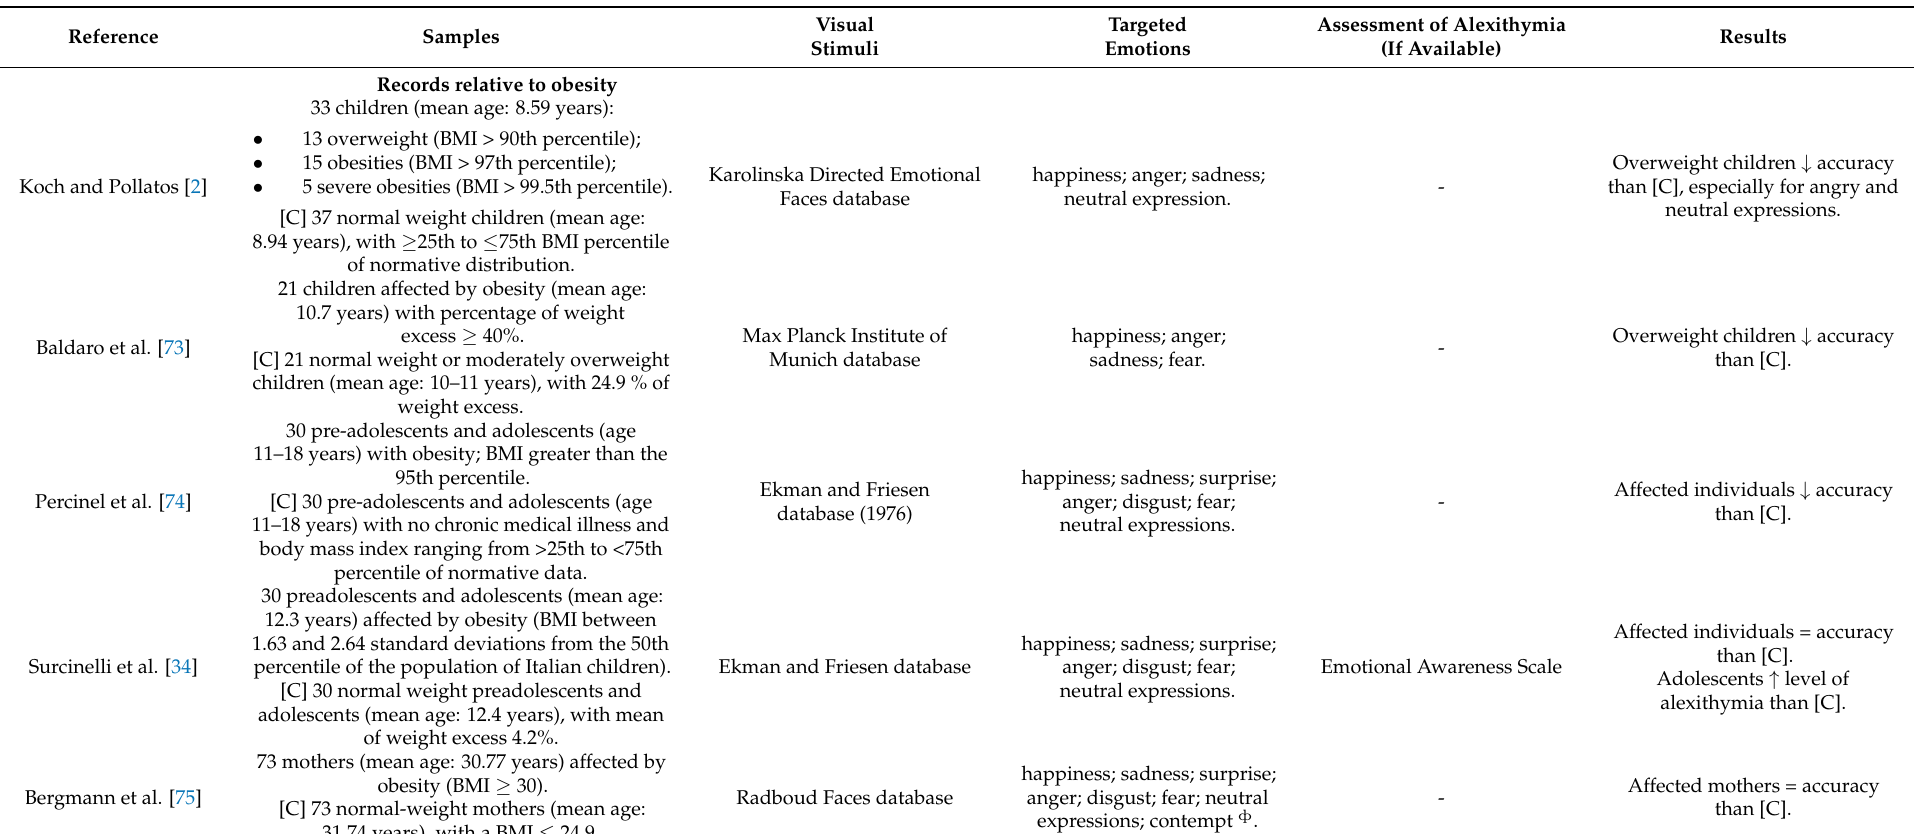
Table 1. Summary of the data extracted from the